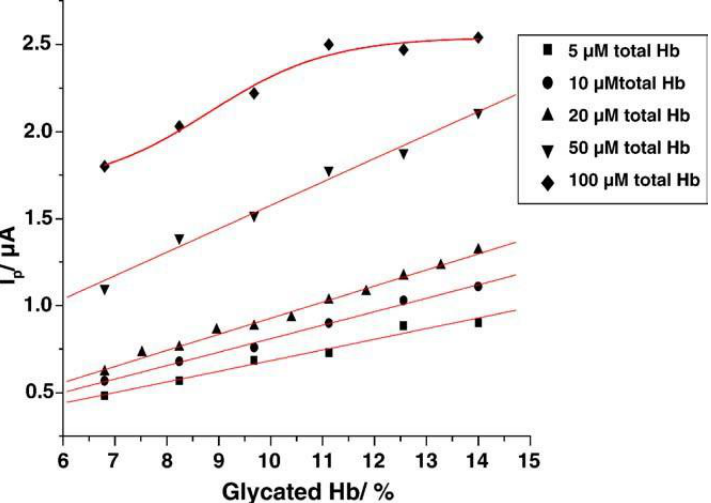
Figure 7. Calibration graphs for HbA1c in samples containing different total concentrations of Hb. The voltammetric peak current was recorded for 3  L sample solutions.